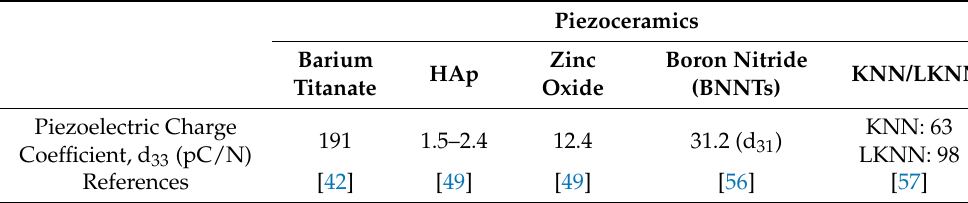
Figure 2. Piezoceramics used for TE applications [51–55]. It should be noted that the chemical structure of piezoceramics is variable, depending mainly on the fabrication process used. Reproduced from Burns and Dolgos [51] with permission from the Centre National de la Recherche Scientifique (CNRS) and The Royal Society of Chemistry. Reprinted from Espitia et al. [52], Copyright 2012, by permission from Springer Nature. Reprinted with permission from Král et al. [53], Copyright 2000 by the American Physical Society. Table 2. Piezoelectric charge coefficient of main piezoceramics applied so far in piezoelectric scaffold ‐ based OCTE strategies.